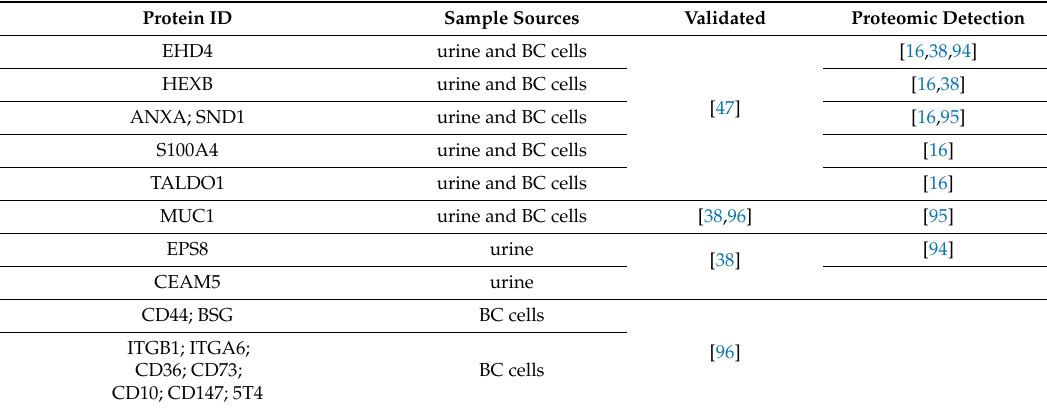
Table 2. List of proteins identified in BC urinary EVs and/or BC cells EVs. Protein